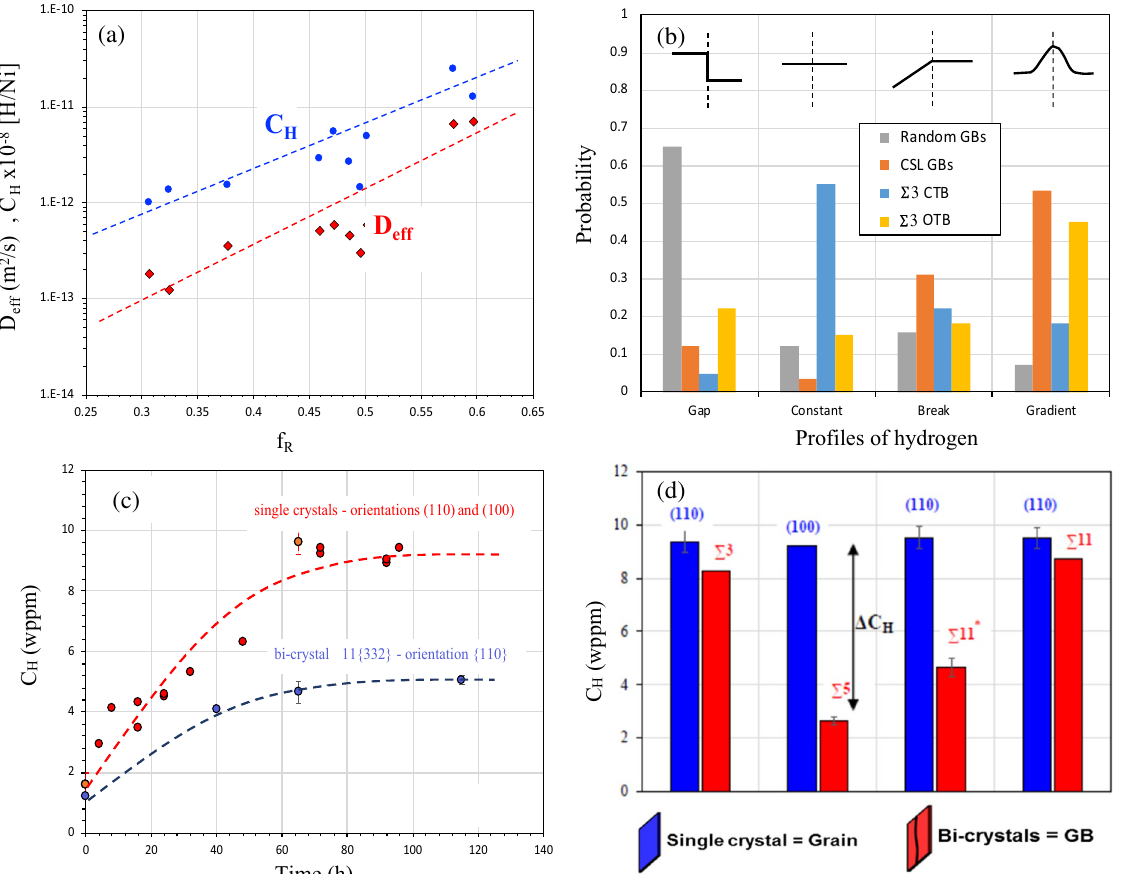
Figure 1. Experimental data collected on the diffusion and solubility in nickel single and polycrystalline pure metal. ( a ) Effective diffusion coefficient D eff and hydrogen concentration C H as a function with the fraction of random grain-boundaries f R (data collected with Oudriss et al. works 28 electrochemical permeation for the same conditions and for different grain sizes between 10 nm to 200 μm). ( b ) Probability to obtain different gradient profiles of hydrogen concentration near GBs obtained by ToF–SIMS (data 29 revisited, CTB Coherent Twin Boundary Σ3, Other Twin Boundary Σ3). ( c ) Hydrogen concentration C H versus charging time for single crystal and Σ11-{332} bi-crystal with the hydrogen ingress orientation along 〈 110 〉 (hydrogen charging at the cathodic current density of 5 mA/cm 2 in 0.1 M NaOH at 300 K). ( d ) Hydrogen solubility C H in single crystals and bi-crystals with different hydrogen ingress orientations: two orientations were studied: {110} and {100} (hydrogen charging at the cathodic current density of 5 mA/cm 2 in 0.1 M NaOH at 300 K for 3 days, Σ3